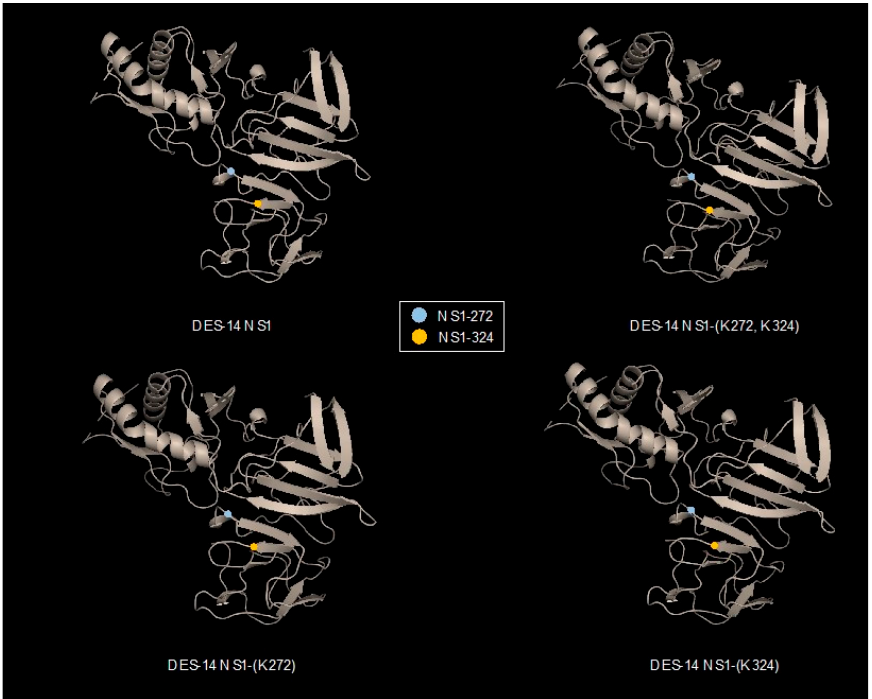
Figure 1. Structural features of DENV-2 NS1 protein. Tridimensional structure prediction of DES-14 NS1 protein (Genbank access number MG189962) and the three mutants DES-14 NS1-(K272, K324), NS1-(K272), and NS1-(K324) was performed by modeling on PHYRE 2 protein recognition server (http://www.sbg.bio.ic.ac.uk/~phyre2/html/page.cgi?id=index; accessed on 23 December 2022). The predicted structures were analyzed with PyMOL 2.5, a program for interactive visualization of tridimensional proteins. The colored dots indicate the positions of residues NS1-272 and NS1-324 in the 3D structure of NS1 protein.